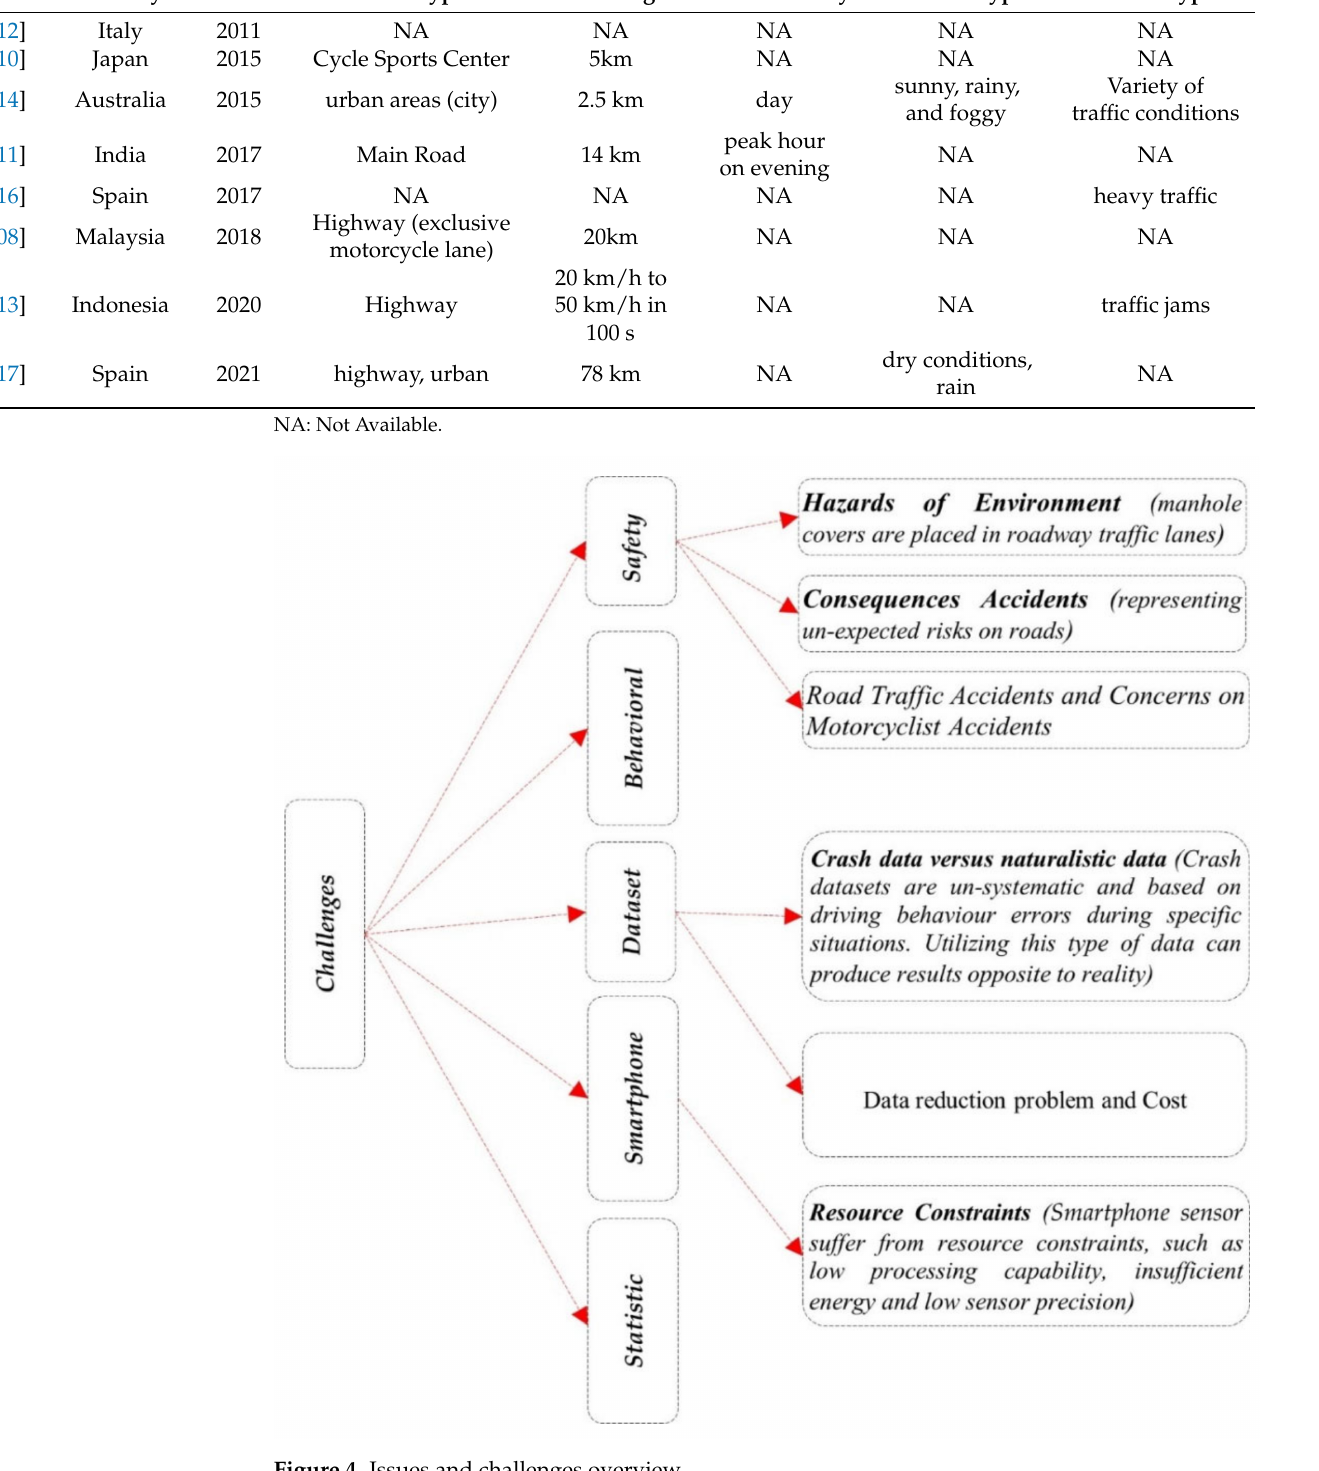
Figure 4. Issues and challenges